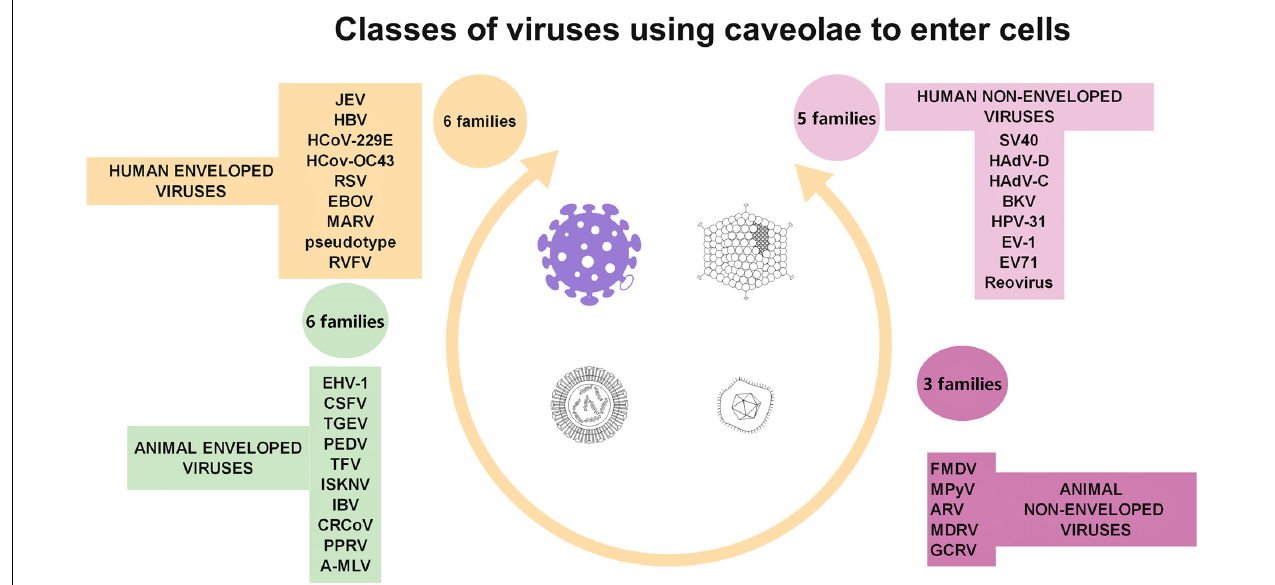
FIGURE 4 | Diagrammatic representation of the four classes of viruses (taking into account virus structure and target cell type) documented to use caveolae as gates to entry cells.